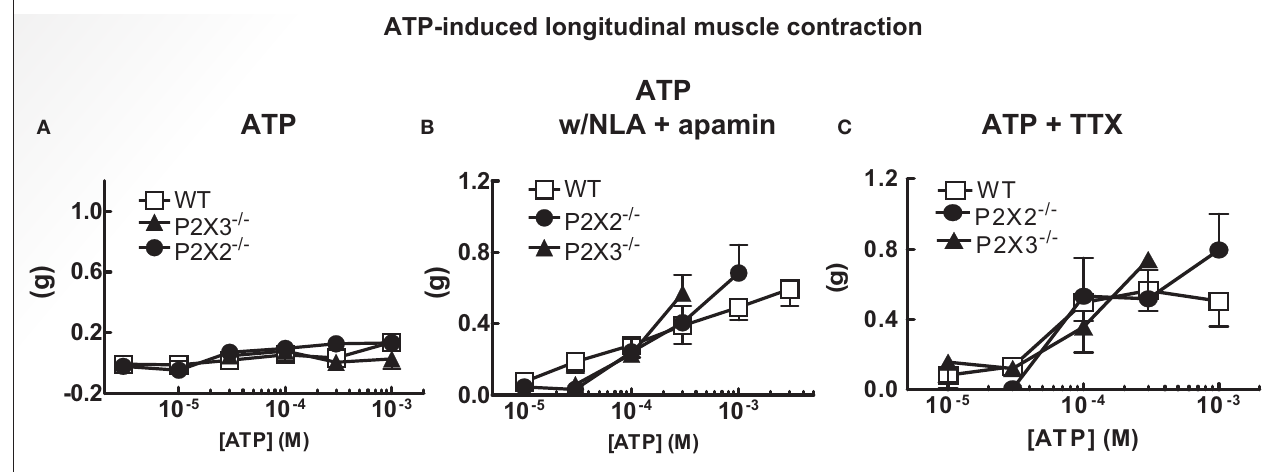
Figure 2 | ATP induced longitudinal muscle contractions in the mouse colon. (A) ATP does not change the resting tone of longitudinal muscle in colonic segments from WT ( n = 14) and P2X2 ( n = 7) and P2X3 ( n = 12) subunit KO mice. (B) . ATP caused longitudinal muscle contractions in colonic segments of WT ( n = 8) and P2X2 ( n = 7) and P2X3 ( n = 4) subunit KO mice when NLA (100 μM) and apamin (0.1 μM) were added to the Krebs’ contractions of the longitudinal muscle when NLA (100 μM) and apamin (0.1 μM) were added to the buffer ( Figure 2B ). There was no difference in contraction amplitude in tissues from WT, P2X2 or P2X3 subunit KO mice ( Figure 2B ). The ATP-induced contractions were not blocked by TTX (0.3 μM, Figure 2C ).